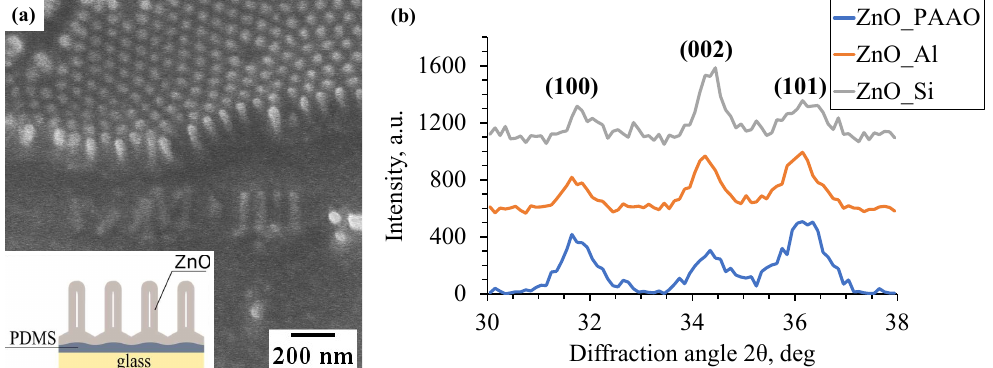
Figure 2. ( a ) SEM image of free standing ZnO NR array obtained by transferring ZnO NR–PAAO hybrid film to a polydimethylsiloxane (PDMS)-coated glass slide and selective removal of Al substrate and PAAO matrix. The inset shows a schematic of the sample morphology. ( b ) XRD spectra of ZnO thin film on Si, electropolished Al and PAAO/Al